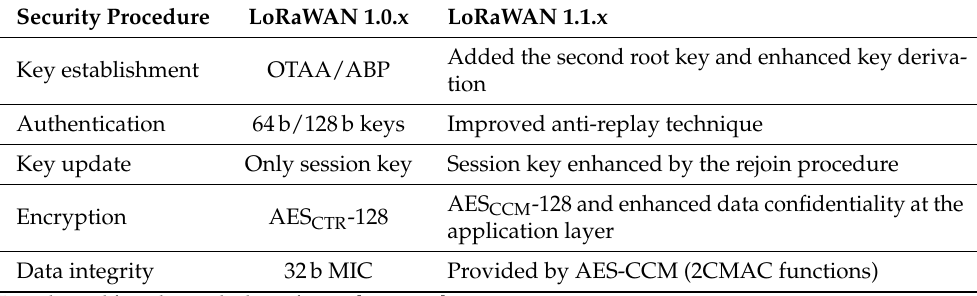
Table 4. Differences in security parameters for LoRaWAN 1.0.x and LoRaWAN